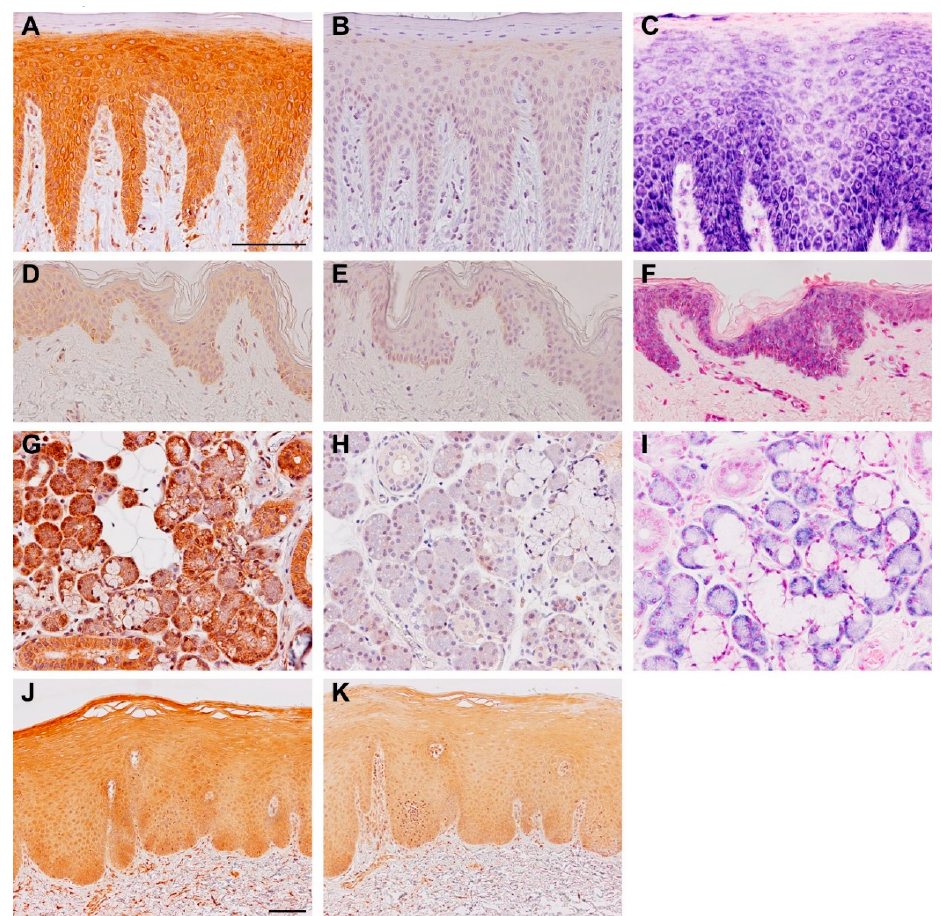
Figure 2. Immunohistochemical (IHC) staining and in situ hybridization (ISH) of sections of oral mucosa ( A – C ), skin ( D – F ), salivary gland ( G – I ), and smokeless tobacco (“snus”; J , K ) for TSLP variants. Left column: IHC staining with anti-TSLP antibody recognizing both lfTSLP and sfTSLP (brown color). Middle column: IHC staining with anti-TSLP antibody recognizing lfTSLP only. As no specific staining is detected in ( B , E , H ), this means that the staining in ( A , D , G ) represents sfTSLP. In oral mucosa exposed to smokeless tobacco, lfTSLP is seen ( K ). Right column: ISH staining by use of sfTSLP-specific probe (blue color) which confirms strong expression of sfTSLP in oral mucosa and salivary gland, and weak expression in skin. Modified from [5].